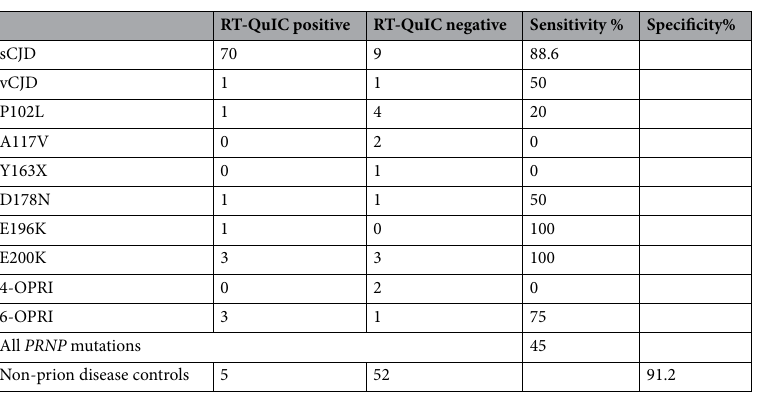
Table 2. Post mortem CSF RT-QuIC results according to types of prion disease (including individual disease- causing PRNP mutations), and non-prion disease controls. This table shows that breakdown of CSF RT-QuIC results according to type of prion disease including sporadic CJD (sCJD), variant CJD (vCJD) and individuals PRNP mutations (P102L, A117V, Y163X, D178N, E196K, E200K, 4-OPRI, 6-OPRI). The sensitivity and specificity of bank vole rPrP RT-QuIC for sCJD is 88.6% (95% CI 79.5–94.7%) and 91.2% (95% CI 80.7–97.1%) respectively, as opposed to the overall sensitivity of all PRNP mutations of 45%.